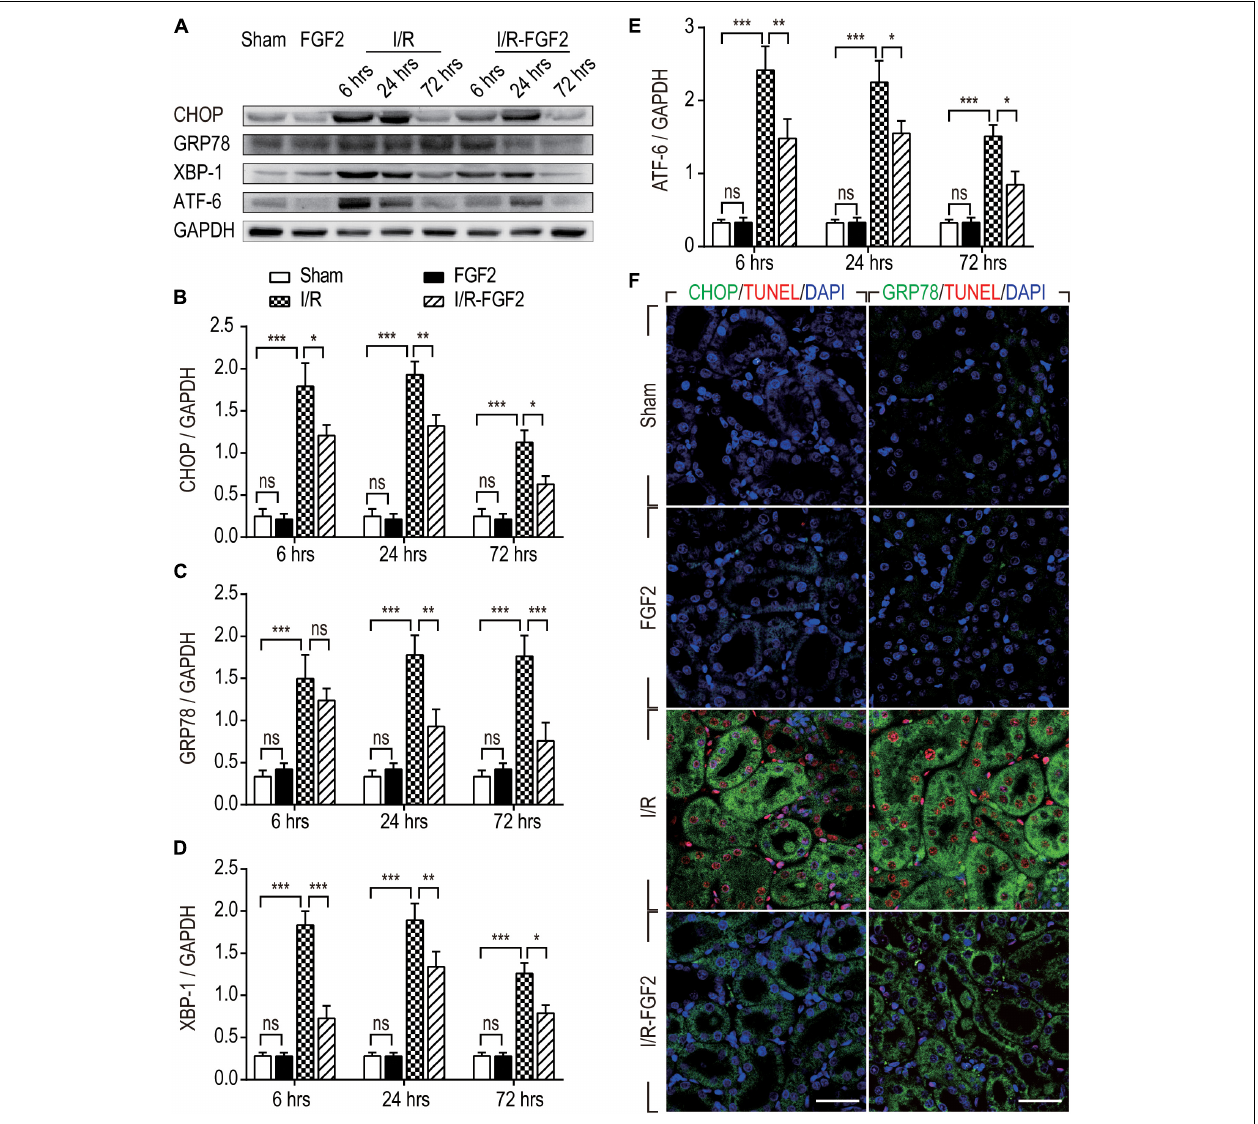
FIGURE 4 | The expression of ER stress-relevant proteins in kidney tissues after reperfusion. (A) The expressions of CHOP, GRP78, ATF-6, and XBP-1 were analyzed with Western blotting. GAPDH was used as a loading control. Images are representative of five animals in each group. (B–E) The bar charts show the normalized optical density analysis. FGF2 treatment strikingly reduced the expression of CHOP, GRP78, XBP-1, and ATF-6. Representative data of five individual samples in each group. (F) Double-staining of CHOP and TUNEL, GRP78 and TUNEL, was detected by immunofluorescence. Images are representative of five animals in each group. * P < 0.05, ** P < 0.01, *** P < 0.001; ns indicates not statistically significant.